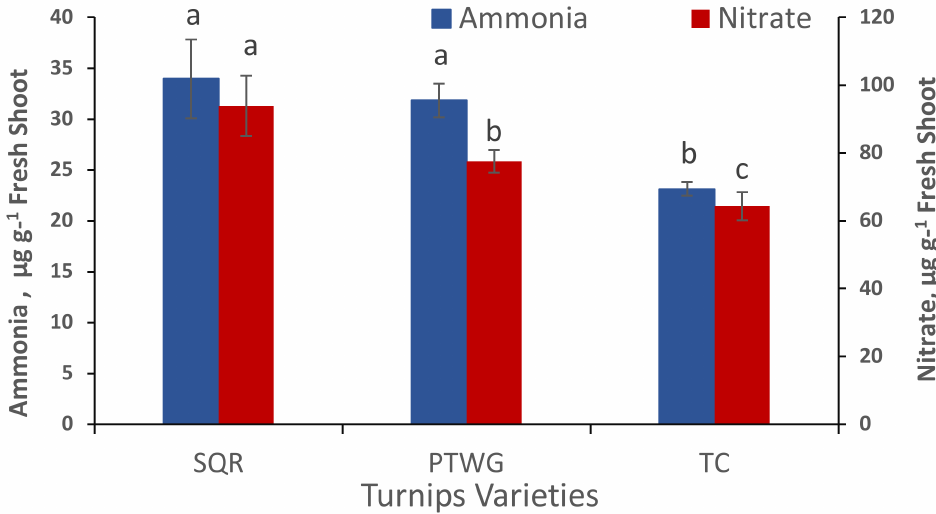
Figure 3. Variability in the concentrations of ammonia and nitrates ± std. error in the shoots of three varieties of turnips: Scarlet Queen Red (SQR), Purple Top White Globe (PTWG), and Tokyo Cross (TC), regardless of soil treatments. Statistical comparisons carried-out among varieties using analysis of variance (ANOVA). Standard errors having different letter indicate significant differences ( p ≤ 0.05) using Duncan’s multiple range test for means comparison.